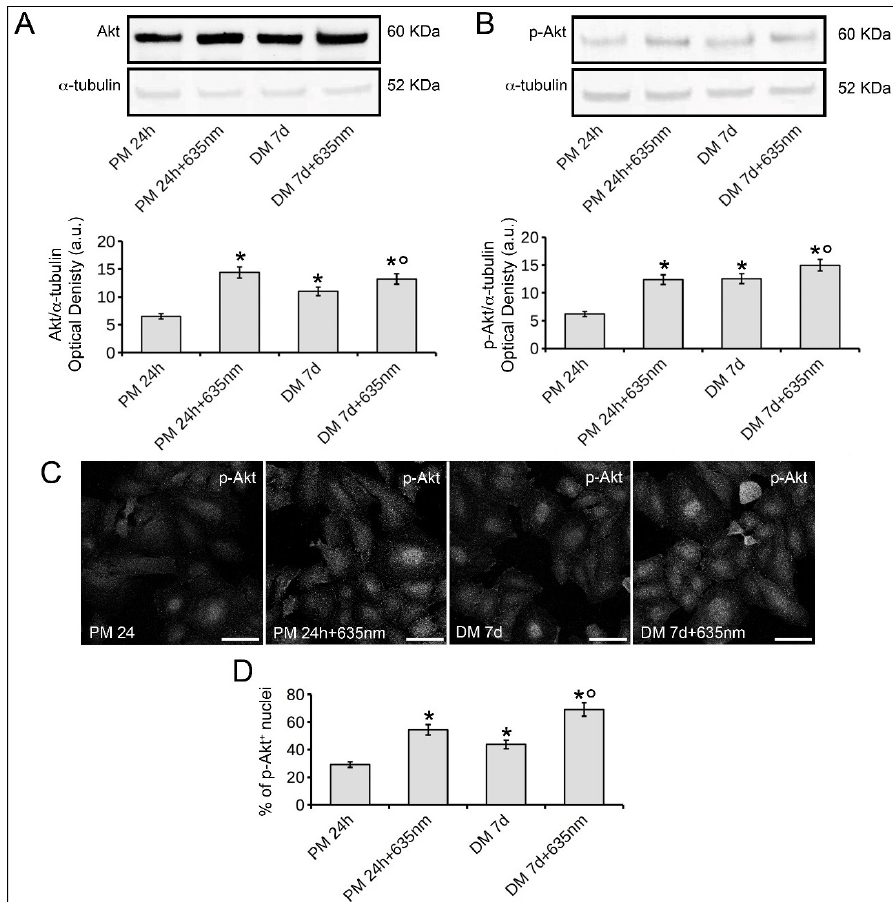
Figure 6. Effects of red PBM on osteoblast Akt expression and activation. Osteoblasts subjected or not to PBM with 635 nm as reported in Table 1, were cultured for 24 h in PM or for 7 days (d) in osteogenic DM. ( A,B ) Western blotting analyses of ( A ) Akt and ( B ) the activated phosphorylated form of Akt, p-Akt, expression. The densitometric analyses of the bands normalized to α-tubulin are reported in the histograms. ( C ) Representative confocal immunofluorescence images of fixed cells immunostained with antibodies against p-Akt. Scale bar: 50 µm. ( D ) Quantitative analysis of p-Akt positive osteoblast nuclei expressed as percentage of the total nuclei number. The data are representative of at least three independent experiments, performed in triplicate. The values are expressed as mean ± S.E.M. Significance of difference: * p < 0.05 vs. PM 24 h, ° p < 0.05 vs. DM 7 days.